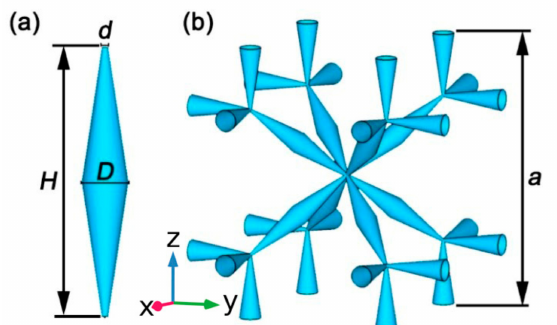
Figure 1. Model and unit cell of the pentamode structure. ( a ) Basic building element of a double-cone. ( b ) Model of pentamode structure in a simple cubic